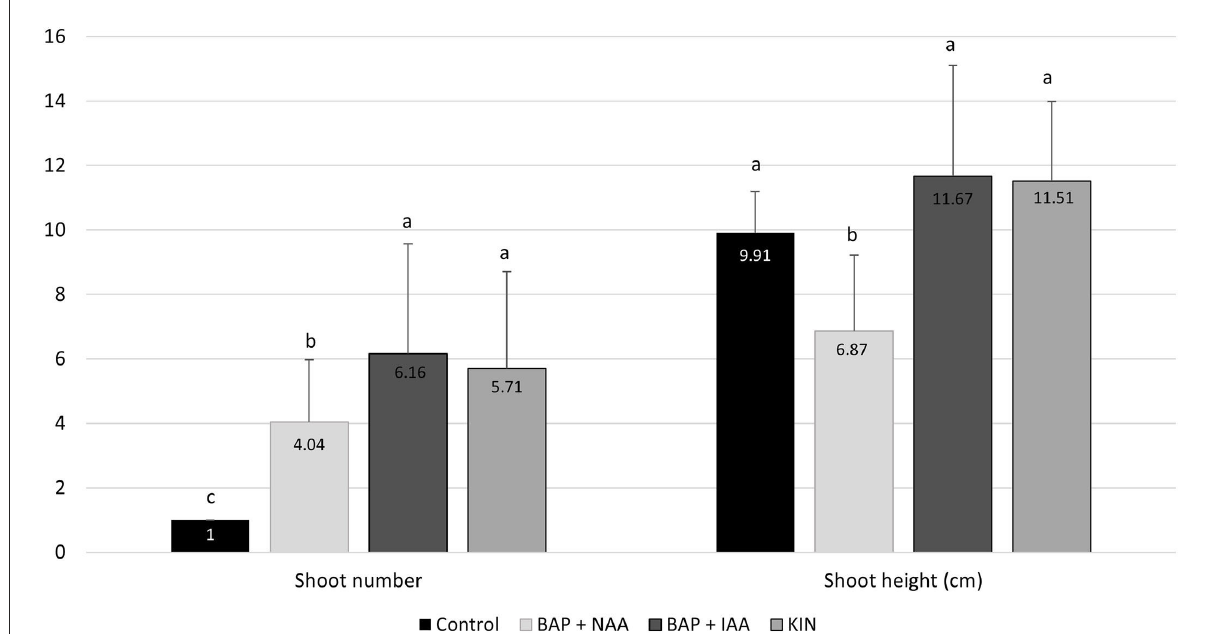
FIGURE3 Effect of the in vitro rooting phase on the shoot number and height of the sea knotgrass cultivated in MS medium derived from the different multiplication media (control, 0.06 mg/L BA + 0.24 mg/L NAA, 3.0 mg/L BA + 0.1 mg/L IAA, and 2.0 mg/L KIN) after 60 days. Values correspond to mean ± SD of three independent experiments ( n = 30). Columns marked with different letters (a–c) are considered statistically different at p < 0.05 (Tukey’s HSD).